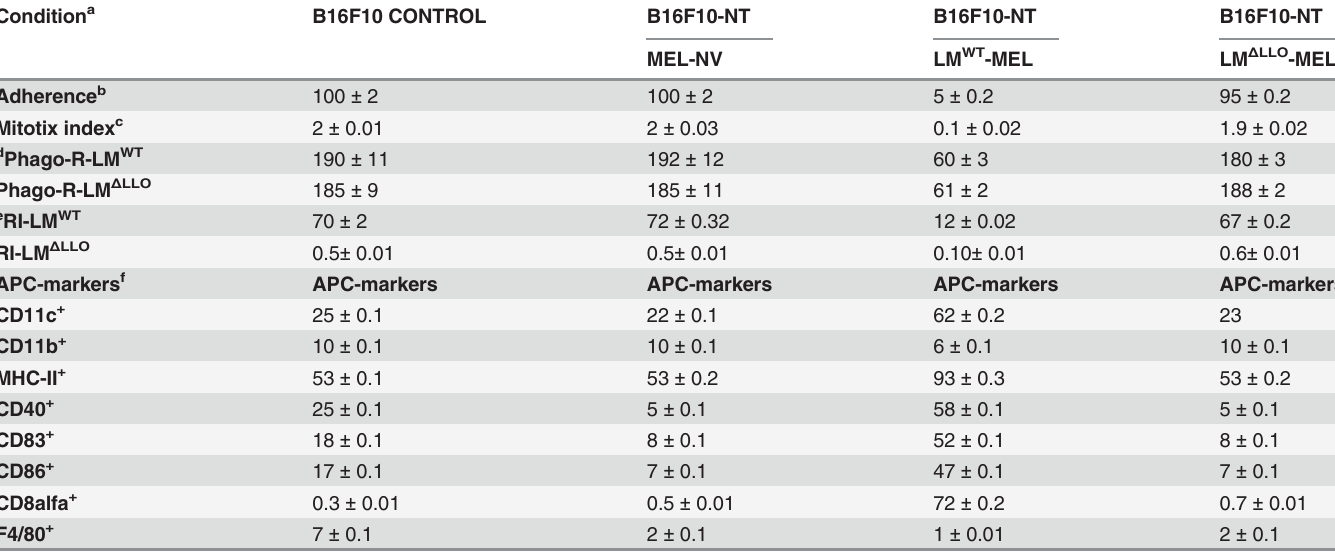
Table 2. Listeria therapy produces modi fi cation of melanoma parameters. Condition